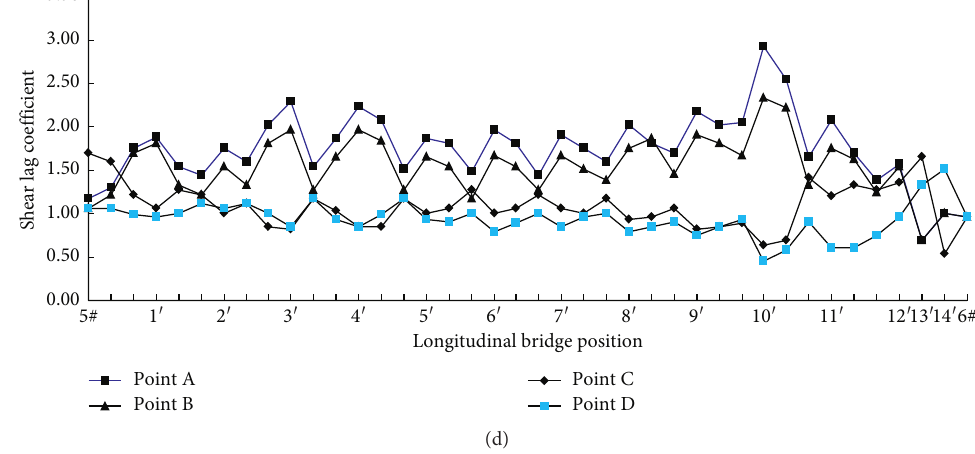
Figure 13: Distribution of shear lag coefficient along longitudinal direction (Condition 4). (a) Left side of Pier 4#. (b) Right side of Pier 4#. (c) Left side of Pier 5#. (d) Right side of Pier